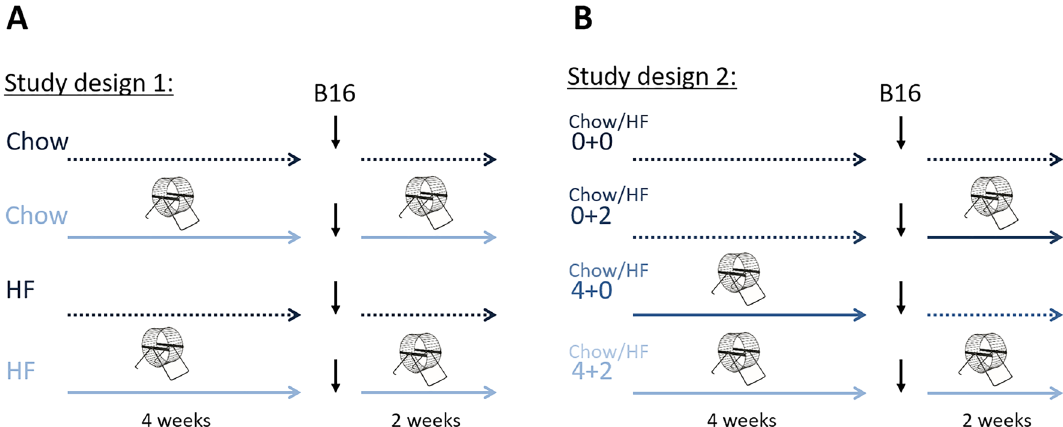
Figure 1. Illustrations of the two used study designs. ( A ) In study design 1, C57bl/6 mice were randomized to cages containing running wheels for 4 weeks prior to tumor inoculation and during tumor challenge (EX) or no running wheel (CON), and further randomized to chow or high-fat feeding (HF) (n = 12). ( B ) In a parallel study (study design 2), mice were randomized to cages containing running wheels for 4 weeks prior to tumor inoculation and during tumor challenge (4 + 2), 4 weeks just prior to tumor inoculation (4 + 0), 2 weeks during tumor challenge (0 + 2), or no running wheel (0 + 0) (n = 12), while either receiving a HF or standard chow